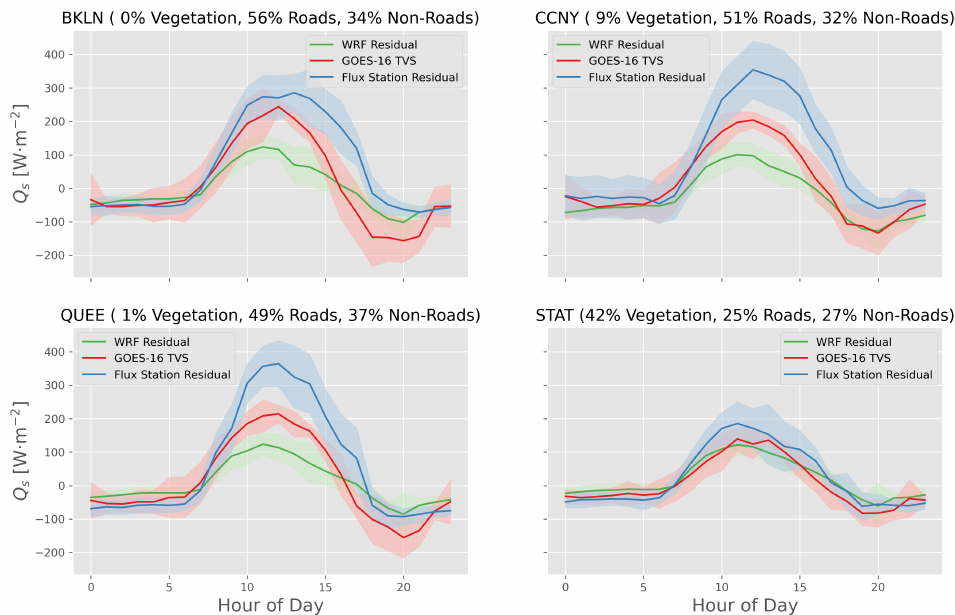
Figure 4. Diurnal comparison for approximately 13 days during August 2019 of heat storage estimates by urban weather and research forecasting model, satellite thermal variability scheme, and surface flux stations for four urban sites in New York City. Standard deviations are shown for each profile of ∆ Q s as